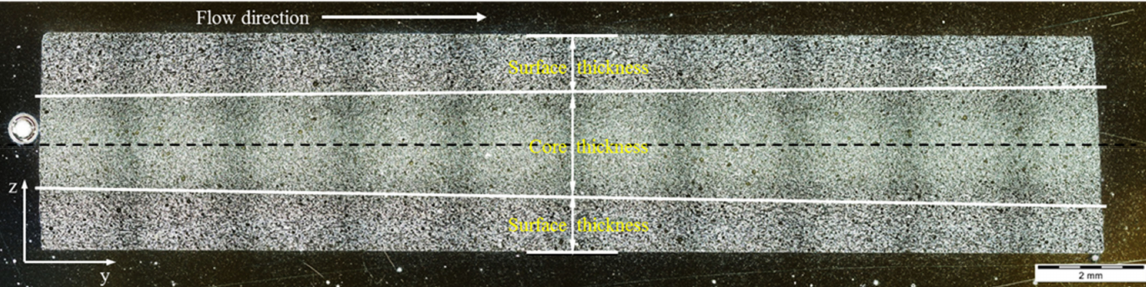
Figure 11. PF6680 (GF25+GB30); influence of surface roughness on the slip phenomenon.